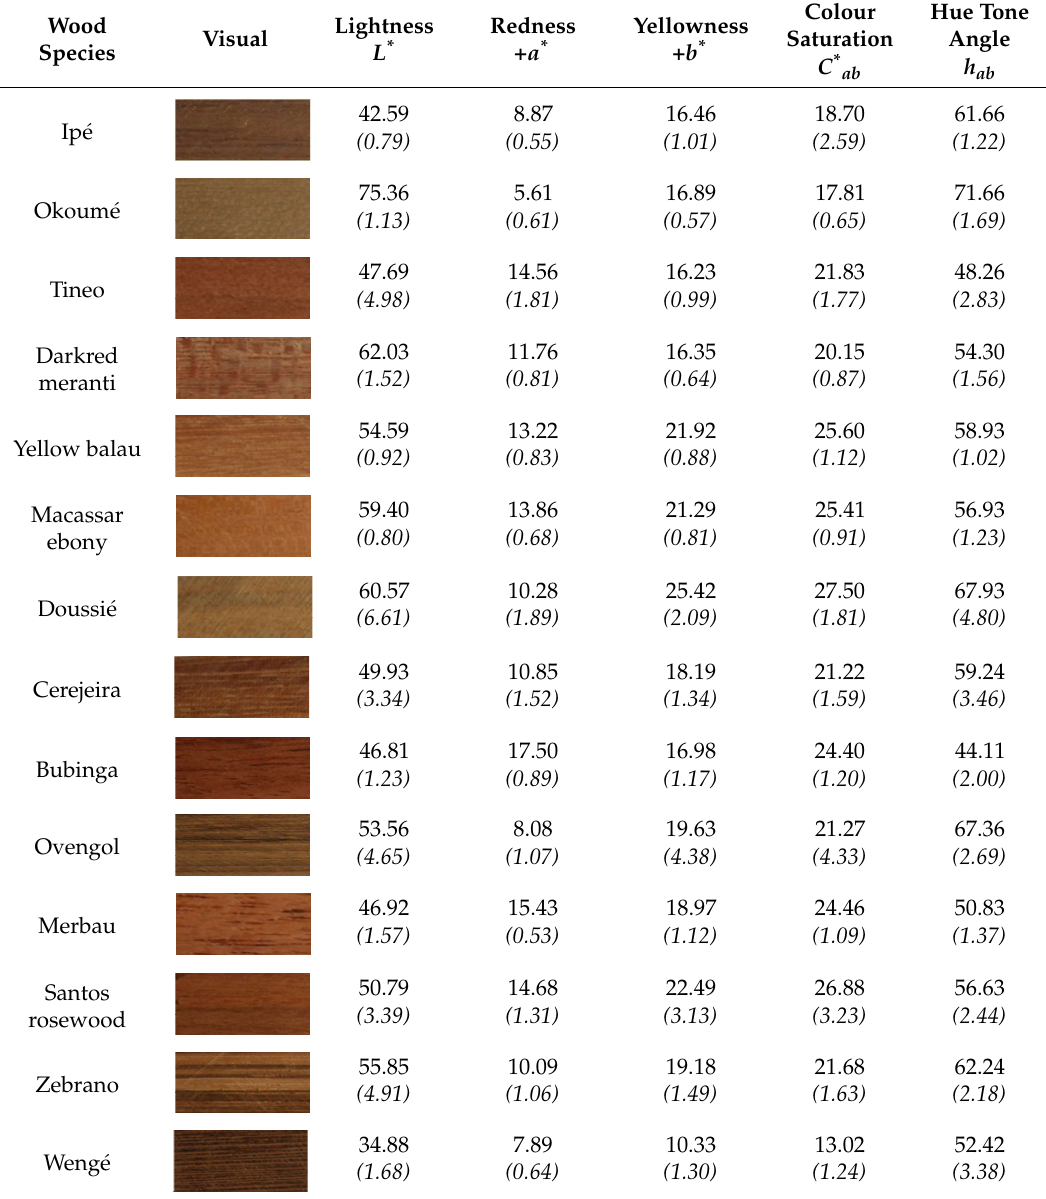
Table 2 documents colour characteristics of 21 tropical woods in the original state—a visualisation (colour and surface structure), and the colourimetric parameters L * , a * , b * , C *ab and h ab . Table 2. Visualisations and colorimetric parameters of 21 tropical woods.